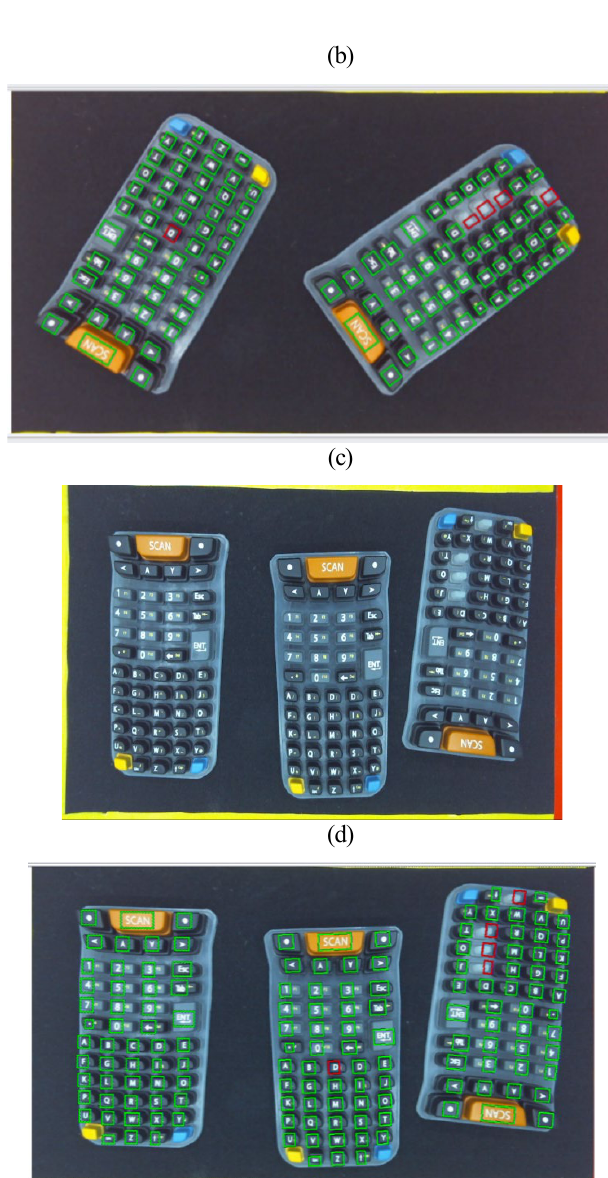
Figure 13. (a) Two input keypads; (b) Resulting image of (a) after applying mode 2 algorithm; (c) Three input keypads; (d) Resulting image of (c) after applying mode 2 algorithm.